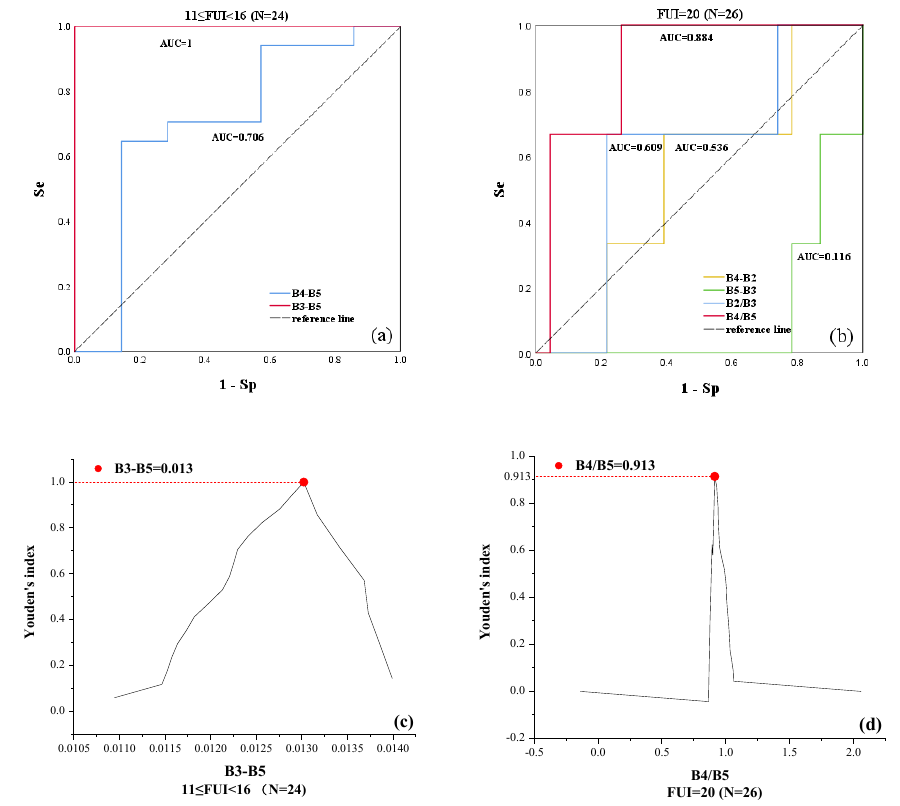
Figure 8. The receiver operator characteristic curve of band combination and Youden’s index when FUI is between 11 and 15 ( a , c ) and when FUI is between 19 and 20 ( b , d ).